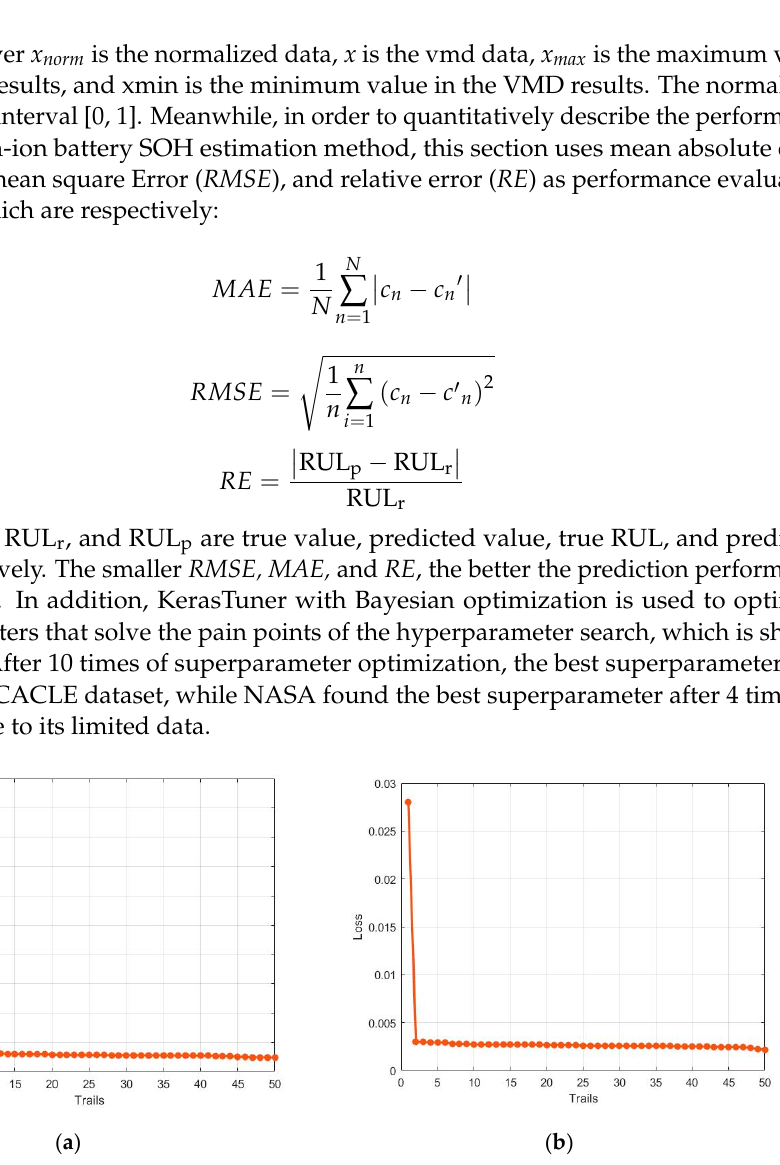
Figure 8. Descending trend of training loss with superparameter optimization: ( a ) CACLE dataset; ( b ) NASA dataset.